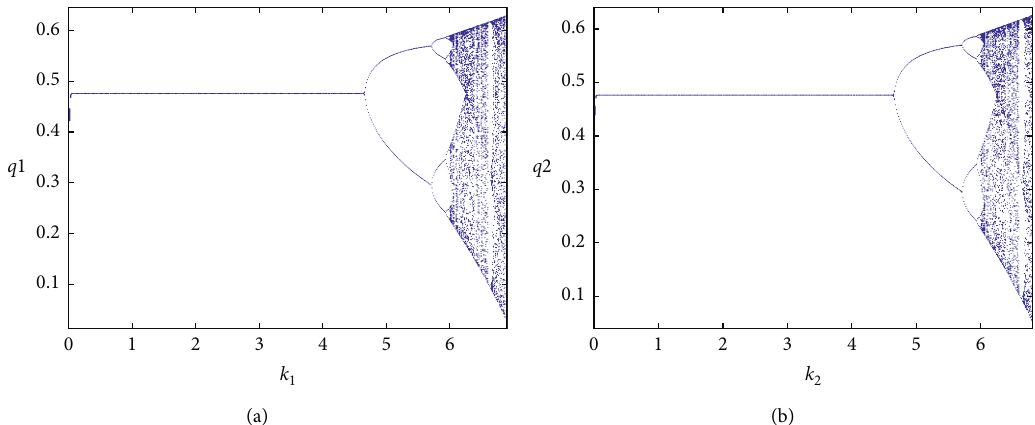
Figure 3: The bifurcation diagram of the model with respect to k